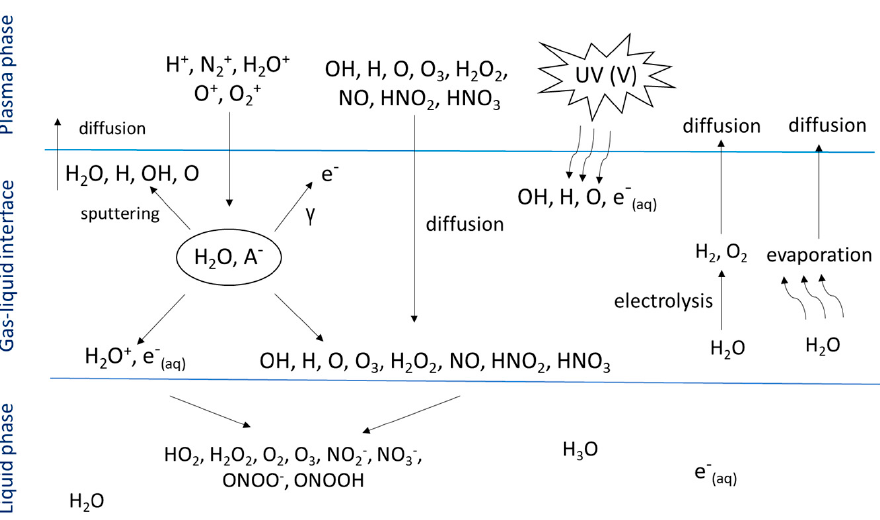
Figure 1. Scheme of migration of reactive oxygen and nitrogen species between phases during plasma water treatment. Adapted from Bruggeman et al. [19].